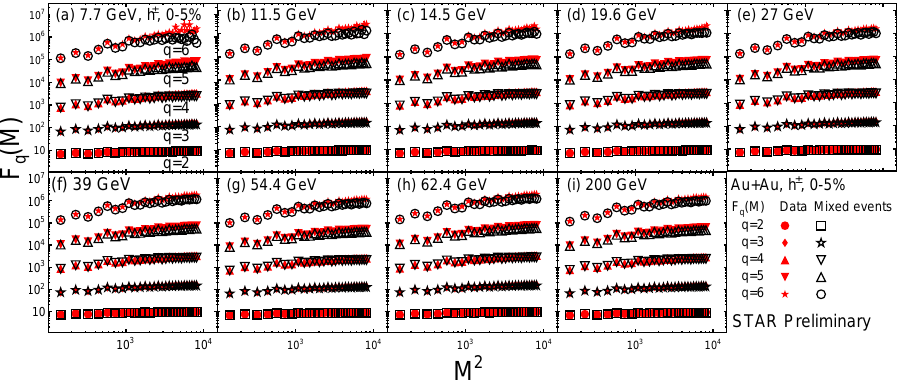
( M ) (up to sixth order) of charged particles in transverse momentum Figure 1: F q space for the most central (0-5%) Au + Au collisions at double-logarithmic